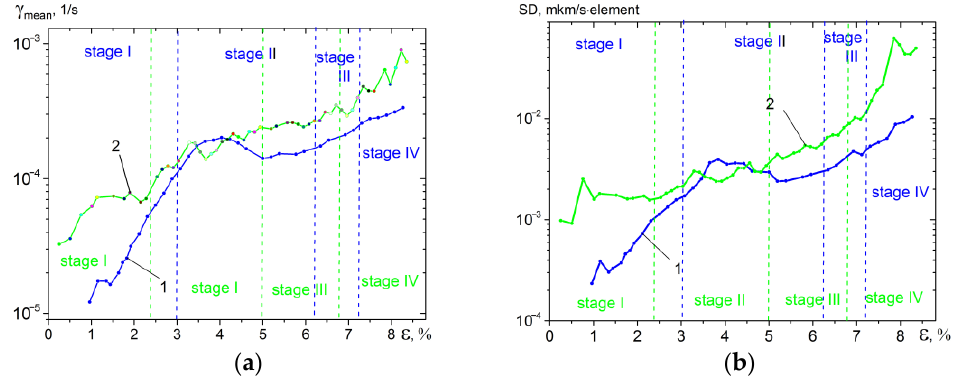
Figure 17. Dependencies of mean CPS vs. strain ε ( a ), standard deviations vs. strain ε ( b ). Sample #1 (1) and Sample #4 (2) data are shown.